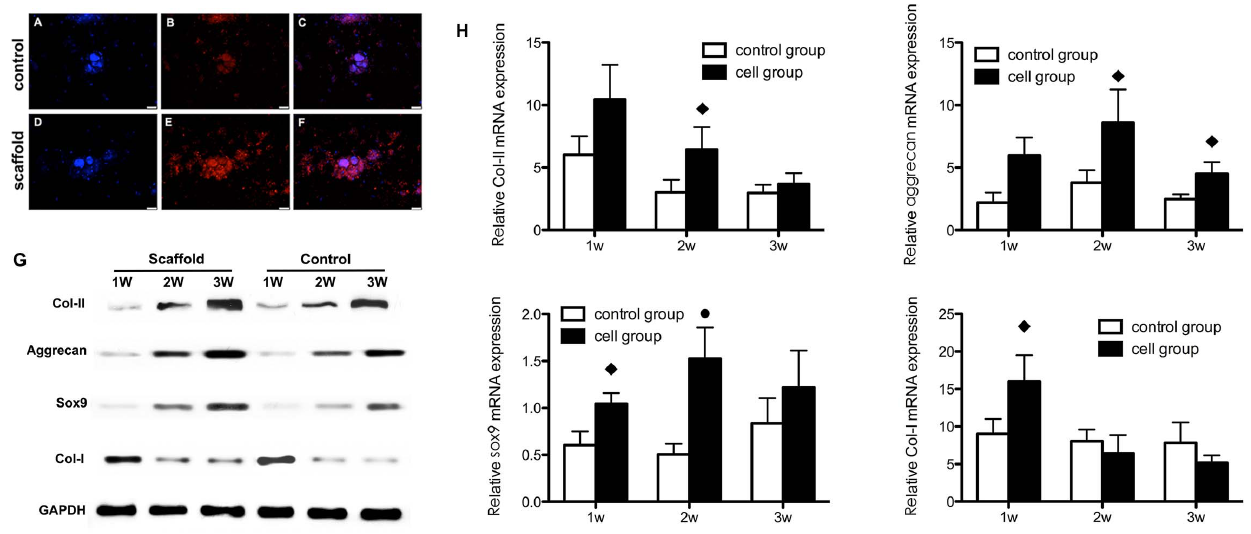
Figure 3. Chondrogenesis of iPSCs cultured on scaffolds (scaffold group) or plates (control group) invitro . Collagen II synthesis in the scaffold group ( A,B,C ) and control group ( D,E,F ) was analyzed by immunofluorescence staining, including nuclear counterstaining with DAPI ( A,D ), anti-collagen II staining in red ( B,E ); merged images are also shown ( C,F ). ( G ) qRT-PCR analysis of gene expression and ( H ) western blotting for collagen II, aggrecan, sox9 and collagen I, using GAPDH as the internal reference. The nanofibrous scaffolds generally enhanced cartilage-specific gene expression and protein levels. ¤ Statistically significant difference compared with the control group ( p , 0.05); difference compared with the control group ( p ,